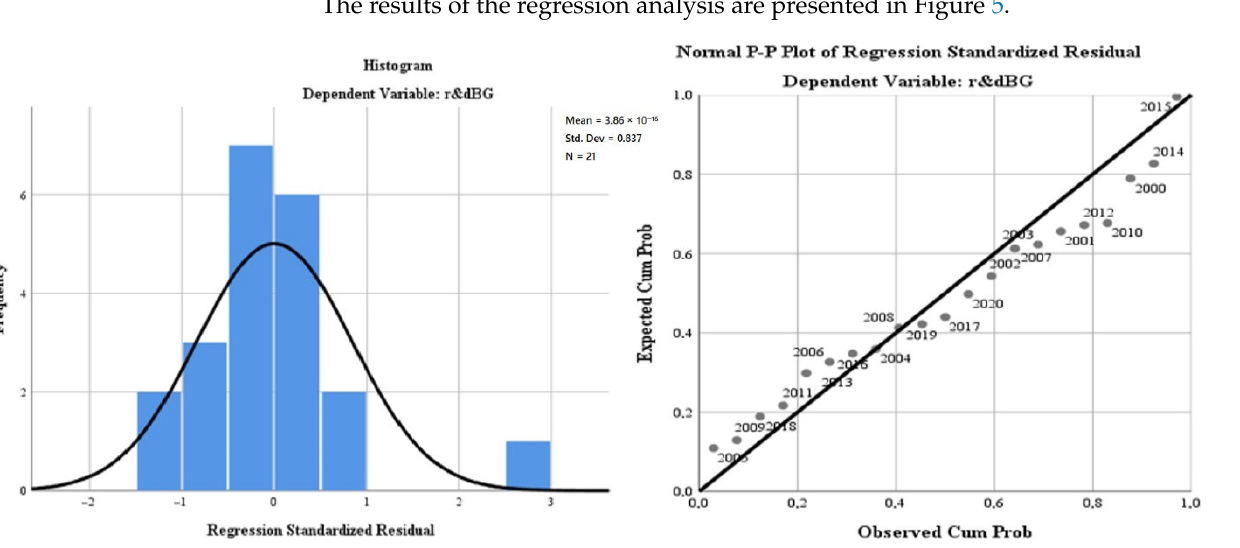
Figure 5. Regression analysis for Bulgaria during 2000–2020. Source: Data operated under IBM-SPSS 25 (IBM, Armonk, NY, USA).